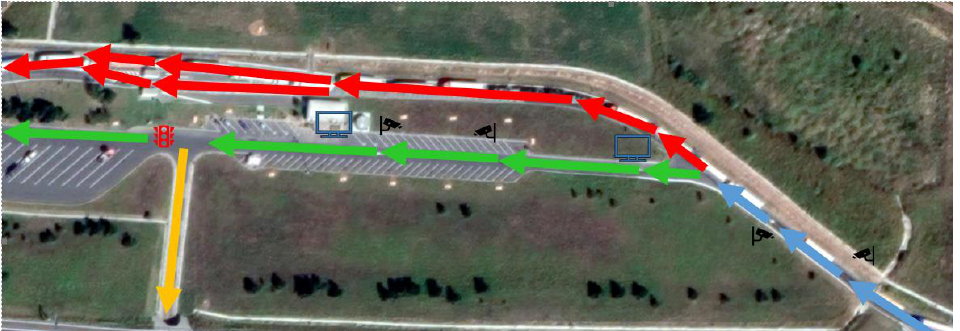
Figure 4. The cargo vehicle flow monitored and controlled with Smart Hub equipment. In blue we see the input flow of cargo trucks from the highway, after the selection process. In red, we see the cargo truck flow going to the weighing equipment. In green, we see the cargo truck flow on a direct lane to BCP. Separating these flows, in orange we see the flow of cargo trucks identified on an incorrect path and forced to make a detour to return to the flows selection point. However, the action of separating the flow of vehicles based on some rules may cause certain blockages in the system ’ s activity. If the number of cargo vehicles guided on a direct path to BCP is too big, the scaling process is blocked by the queue made by these ones. In the opposite situation, the large number of cargo vehicles guided to the scaling equipment can block all vehicles, even the ones guided on direct path to BCP. The limited slot for a direct path to BCP is implemented in practice using a space which is not currently in use. This access road will be arranged by the high- way administration to allow access according to the rules presented in this paper. The views from the site are present in Figure 5. In the first image, the actual utilization of the free lane is presented. In the initial project, there was supposed to be a service area here. The formation of a queue of cargo vehicles on the highway and on the access connection to the parking lot blocks the access of cars in this area. In images (b) and (c) we see the access to the scaling area and the actual equipment used. For the research, the most im- portant factor is the separation area presented in the last image where the equipment for traffic control and monitoring will be installed. ( a ) ( d ) Figure 5. The important area from the BCP. ( a ) The unused lane proposed as a new path; ( b ) The scaling area; ( c ) The actual equipment for traffic control; ( d ) The proposed flows separation area. Another aspect with impact on the system’s activity is the uncertainty that may ap- pear in the data obtained from the external source. In Figure 3, the last class used to